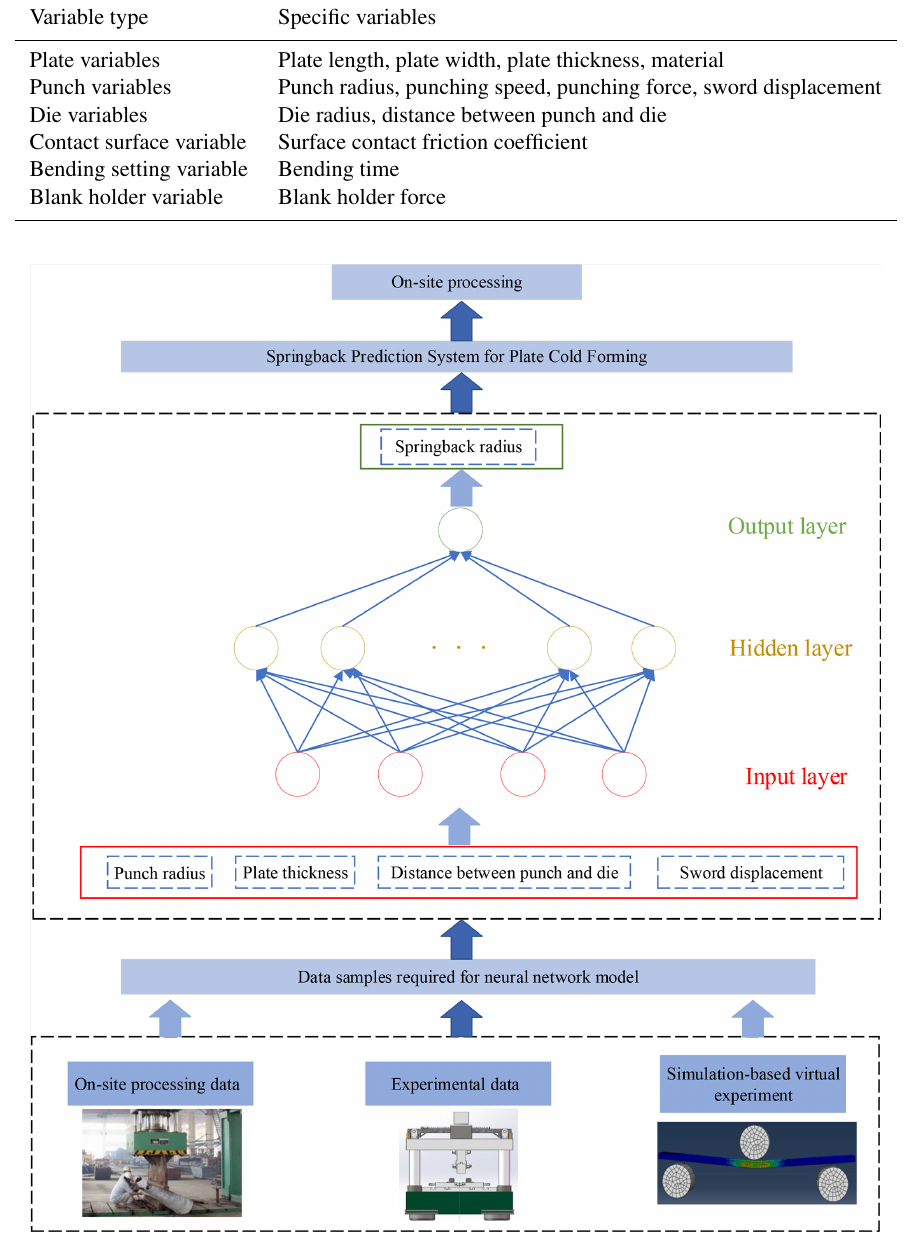
Figure 4. System process steps of plate cold